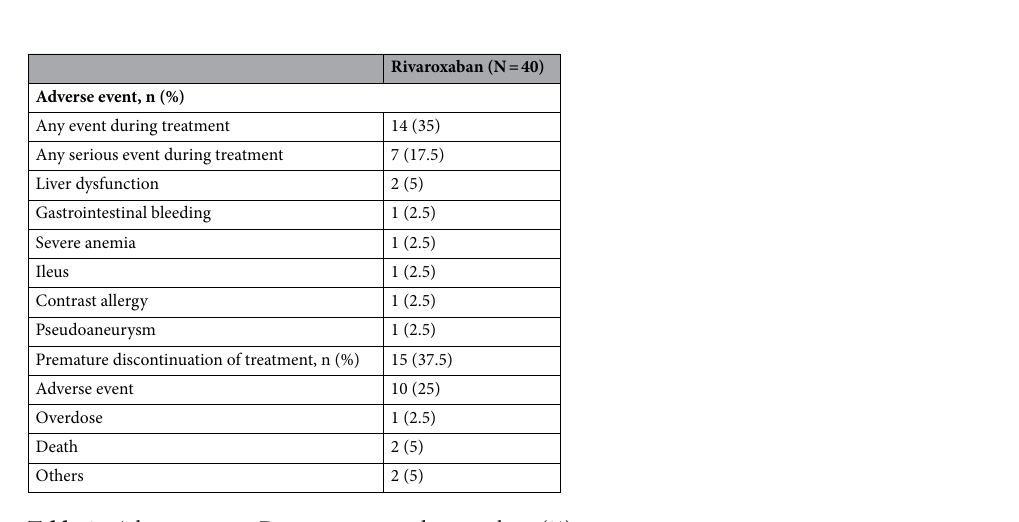
Table 4. Adverse events. Data are presented as numbers